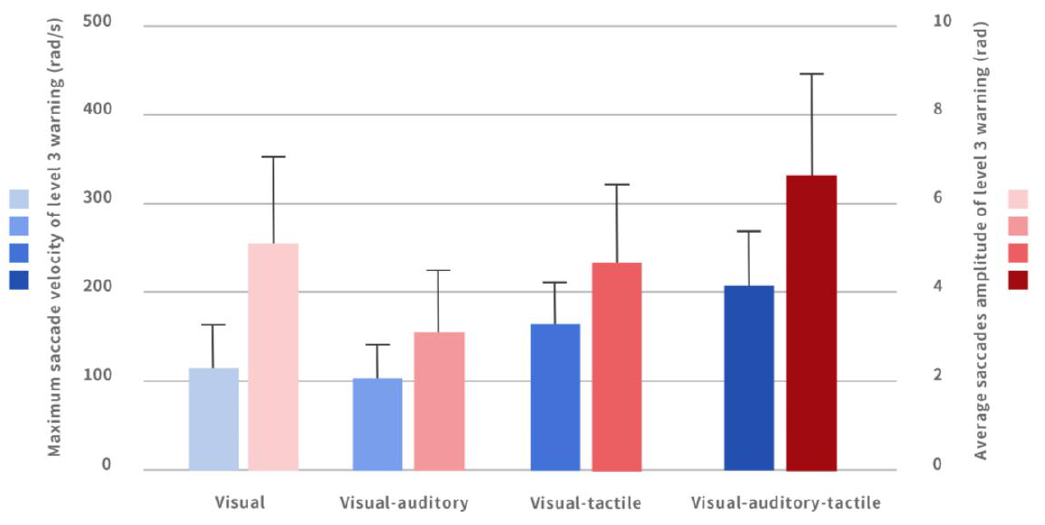
Figure 4. Maximum saccade velocity and average saccade amplitude of level 3 warning interface under different warnings.